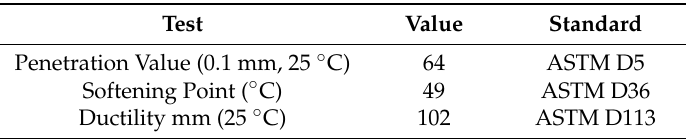
Table 1. Properties of Base Binder.